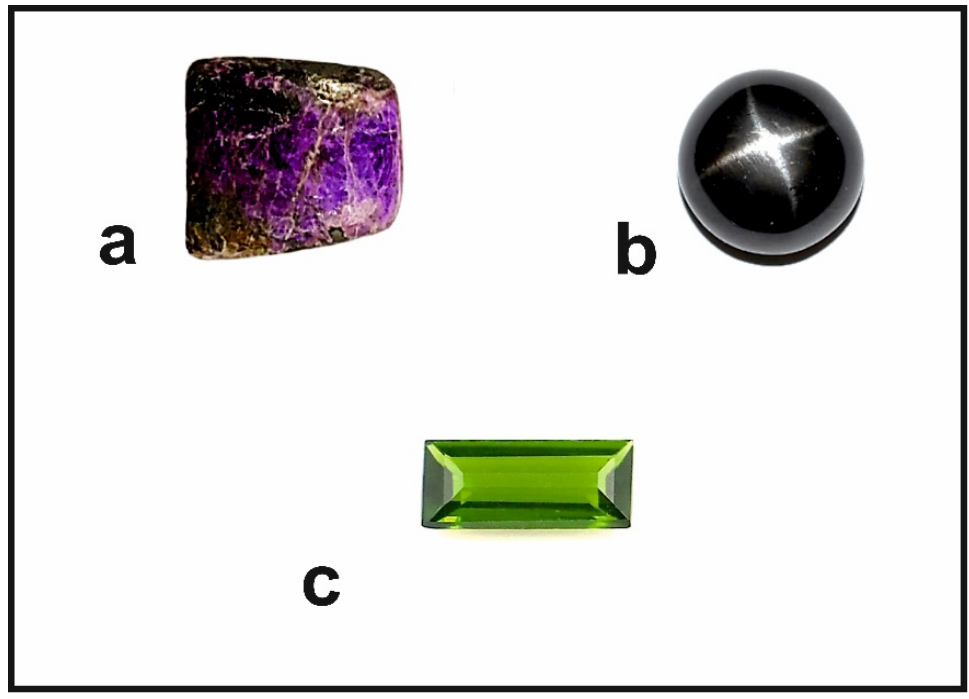
Figure 1. Photographs of somegem ‐ quality diopsides: ( a ) “violane” (Praborna mine, Valle d’Aosta, Italy; 16 mm × 9 mm × 7 mm); ( b ) “black star” (Queensland, Australia; 10 mm × 7 mm); ( c ) Cr ‐ diopside (Yakutia, Russia; 11 mm × 6 mm × 4 mm). Private collection of the author F.C. Photo Franca